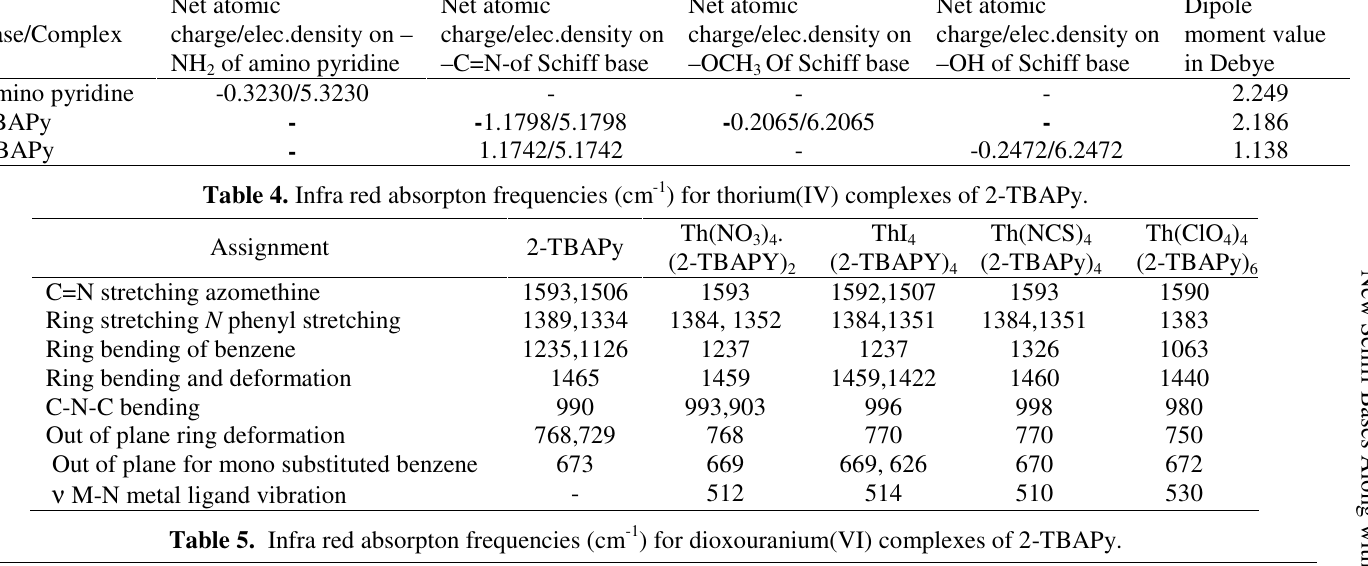
Table 3. AM 1 calculation results.